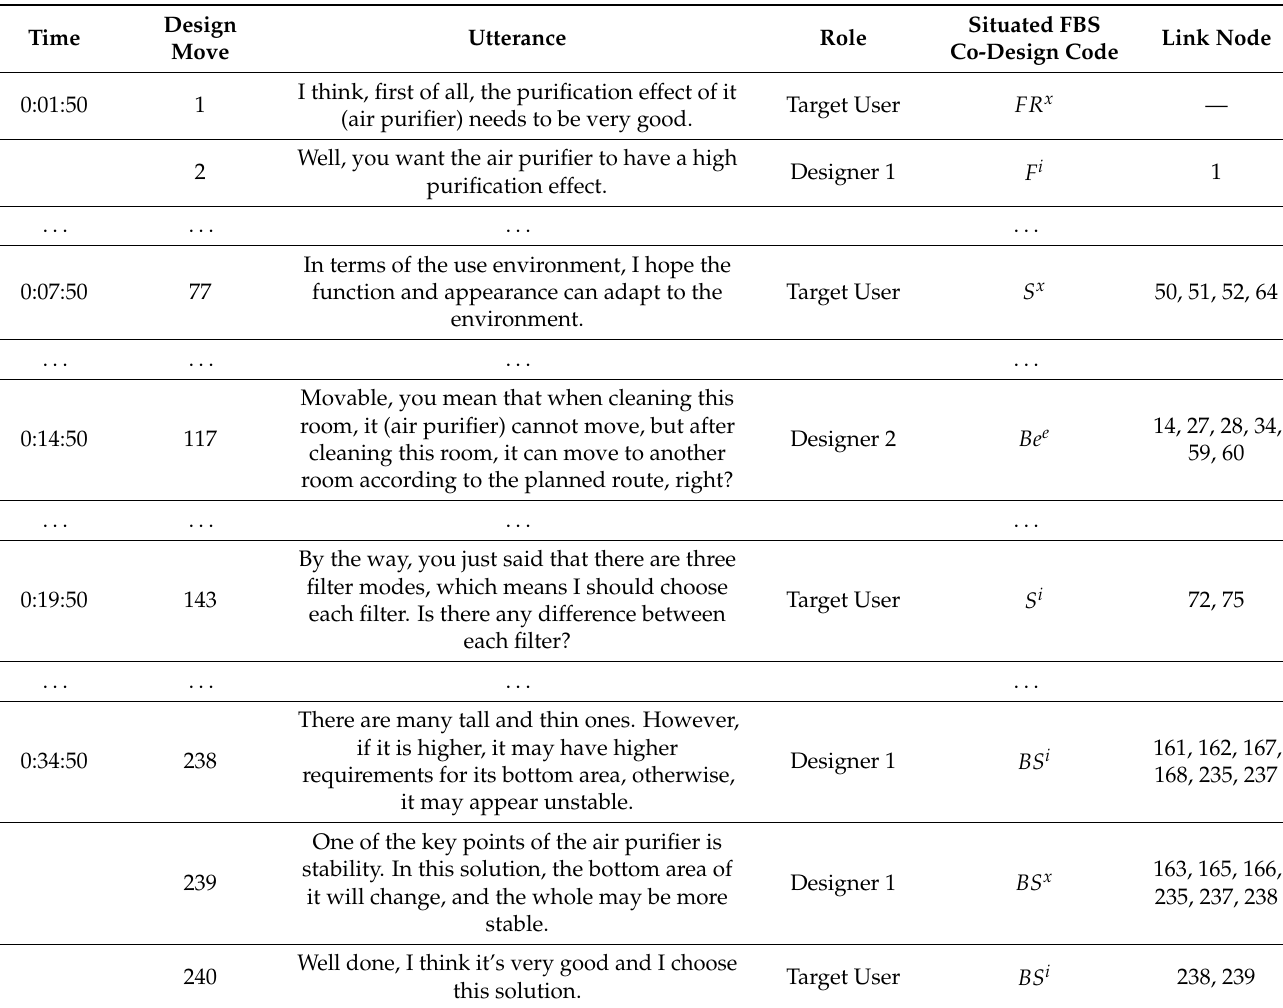
Table 3. The coding results of the protocol